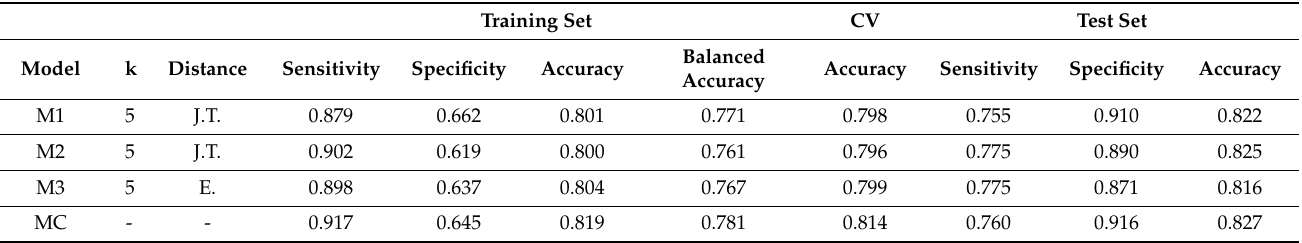
Table 4. Performance of the models. The distances J.T and E. stand for Jaccard Tanimoto and Euclidean, respectively. The cross-validation (CV) is 5-fold. Training Set CV Test